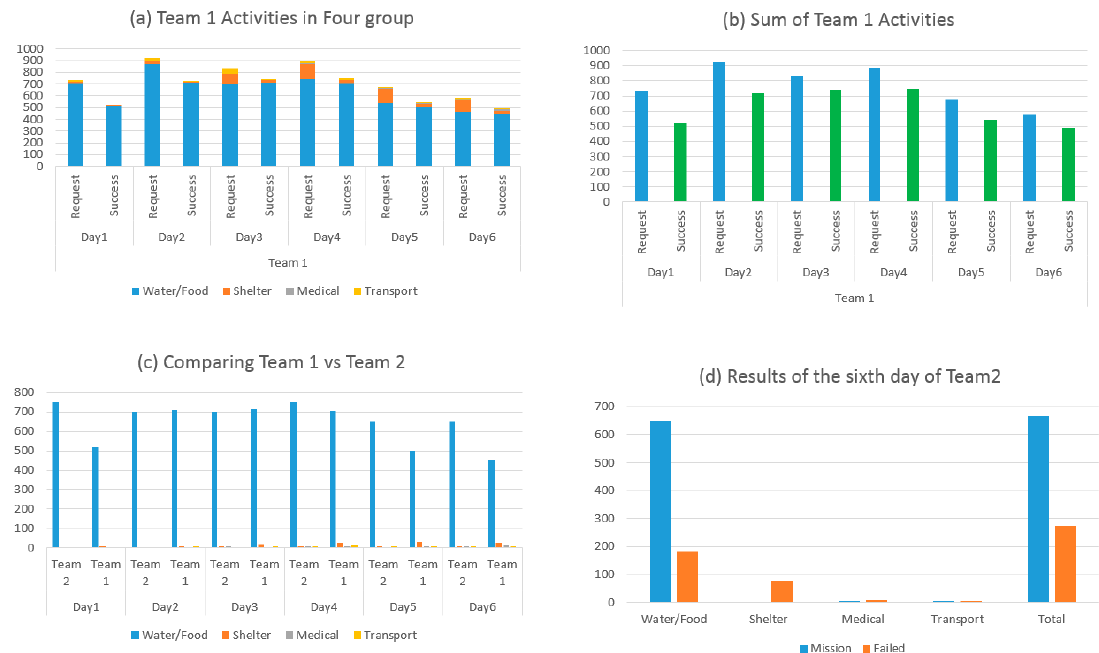
Figure 11. ( a ) The diverse activities of Team 1, also highlight their success rate in solving the problems in six days ( b ) Sum of all Team 1 activities and their success rate in six days, ( c ) Compare the number of activities performed by Teams 1 and 2, ( d ) Results of the sixth day of Team 2.